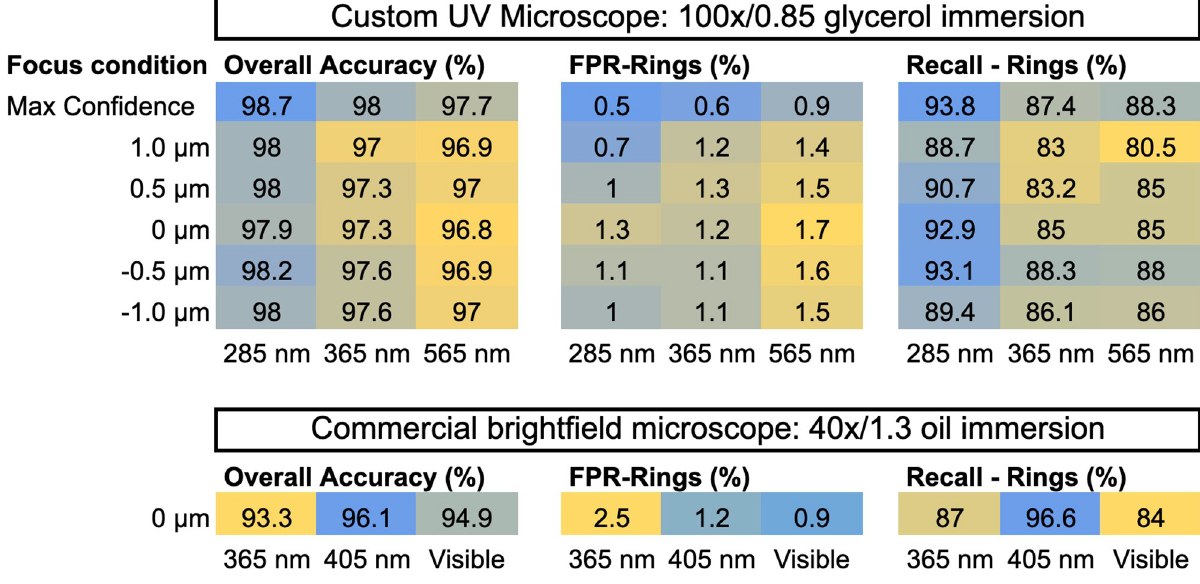
Fig 6. Wavelength- and slice-dependent classification statistics on the custom UV microscope. Top: Overall accuracy (left), FPR for rings (center), and recall for rings (right) were selected for detailed breakdown as a function of wavelength (columns), and focal offset (rows). The top row in each table shows the result of processing the data with our maximum confidence strategy for focal plane selection on a cell-by-cell basis. Bottom: The same statistics were plotted for a single focal plane on the commercial light microscope at 40 × magnification. For each grouping by microscope and statistic, cells are color-coded on a scale from blue (lowest performance) to yellow (highest performance). All statistics were derived from multi-wavelength datasets, which consisted of distinct but partially-overlapping sets of data with single-wavelength datasets (see Table 1). In both cases, each wavelength- specific classifier was trained and validated uniquely on images at its particular wavelength. To ensure a fair comparison between the wavelengths, all three wavelengths for each microscope shared the exact same random partitions between training and validation, ie. the same distinct sets of RBCs and corresponding ground truth labels were used across